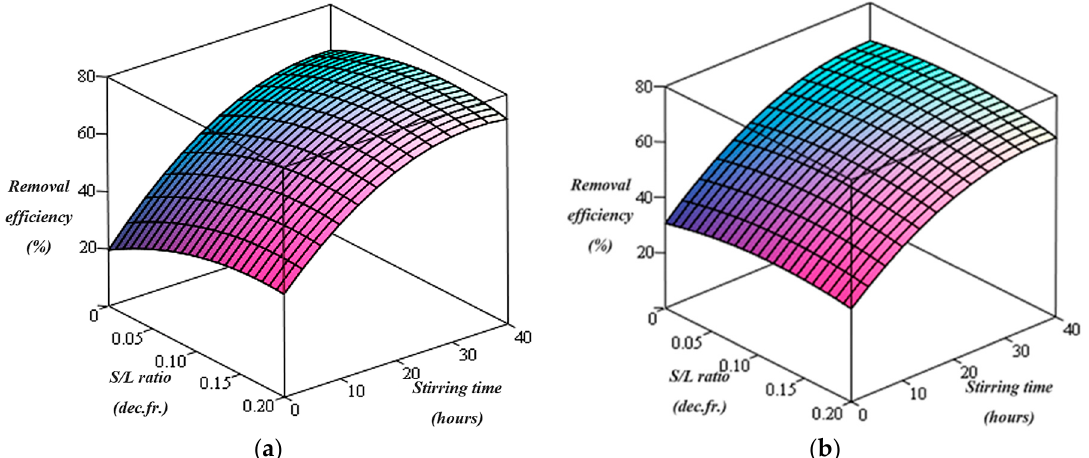
Figure 2. Pb removal efficiency using chitosan for ( a ) C = 2% and ( b ) C = 5%.